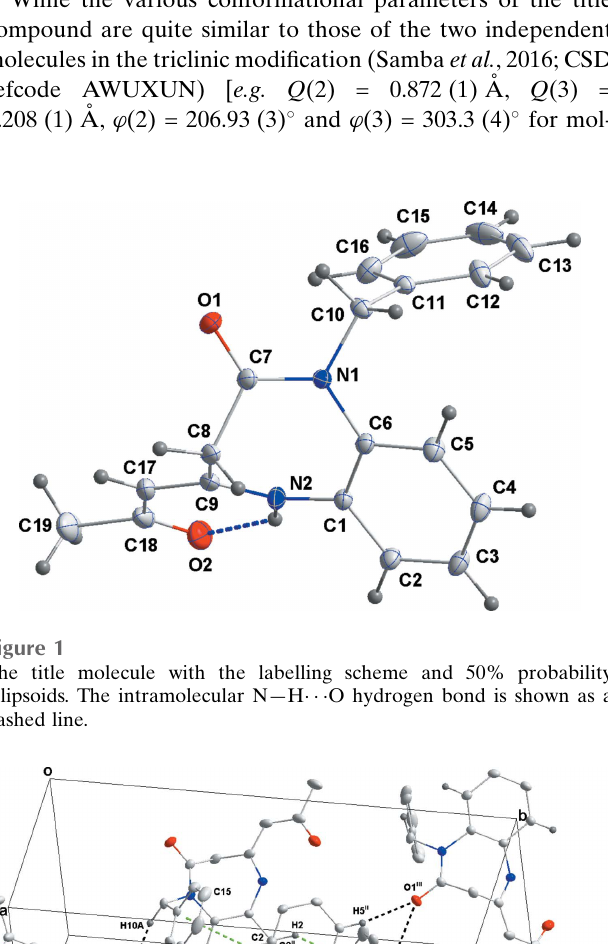
the same side and are joined into sheets lying parallel to (101) by complementary C2—H2 (cid:2) (cid:2) (cid:2) (cid:2) ( Cg 2) iii interactions (Table 1 and Figs. 2 and 3).